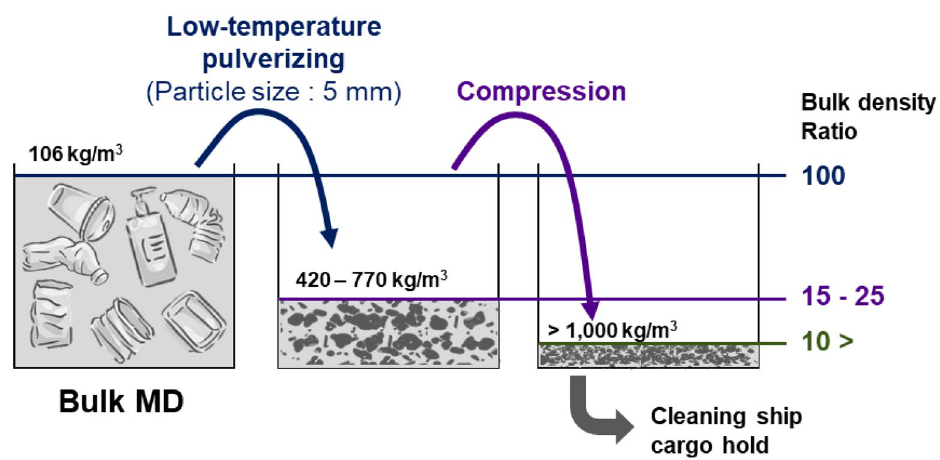
Figure 7. Storage efficiency according to the stages of MD treatment. Bulk MD contains seawater and has poor storage efficiency due to its low bulk density. Even if only the pulverizing process is carried out, it is possible to achieve a storage efficiency of more than five times and is expected to store more than 10 times through compression 69